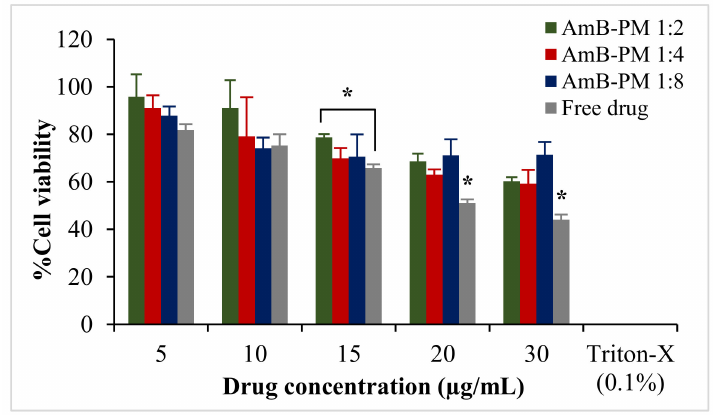
Figure4. ViabilityofCaco-2cellsafterincubationwithAmB-PMandfreedrugfor4h. Dataarepresented